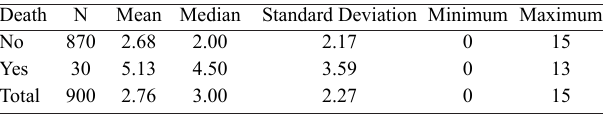
Table 2. Comparison of EuroSCORE according to RTI.